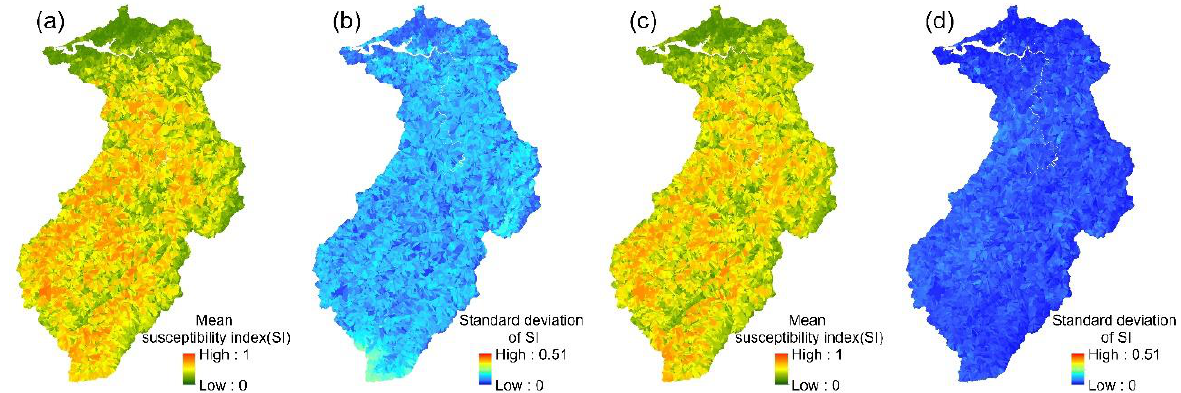
Figure 11. PMW ensemble models: ( a , b ) the mean susceptibility index and standard deviation of 24 event-based models; ( c , d ) the mean susceptibility index and standard deviation of the multi-year model.